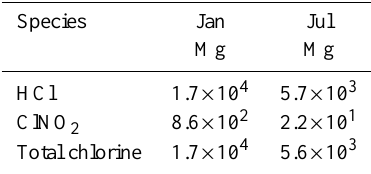
Fig. 6. Total natural chlorine (HCl+ClNO 2 +sea salt Cl) emissions, expressed as Mg of Cl, calculated for January (top) and July (bottom) 2002 for the atmospheric modeling domain. Table 3. Monthly emissions totals for naturally occurring chlorine gases within the atmospheric modeling